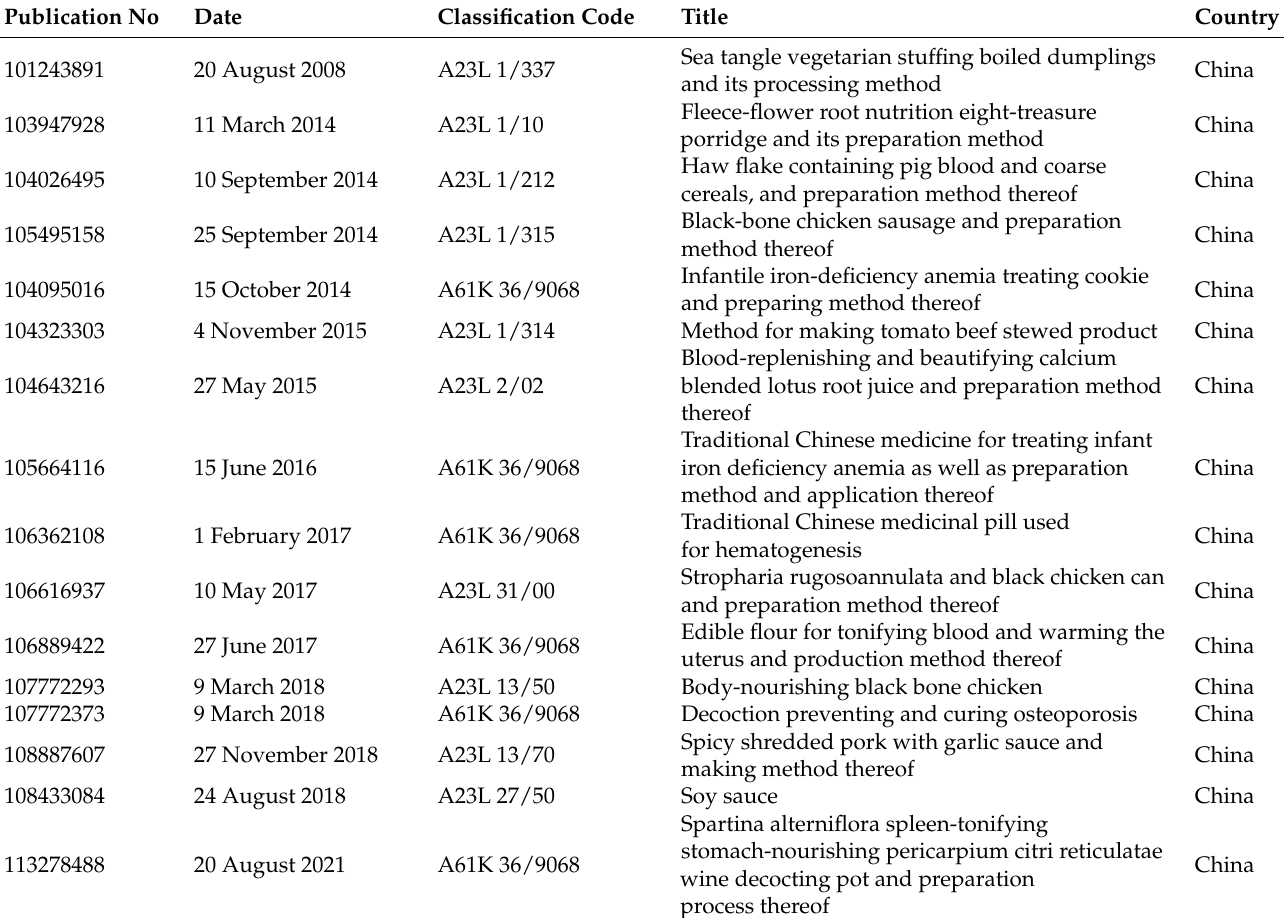
Table A1. A summary list of patent publications related to functional foods or ethnomedicine indicated for iron deficiency with ginger as an